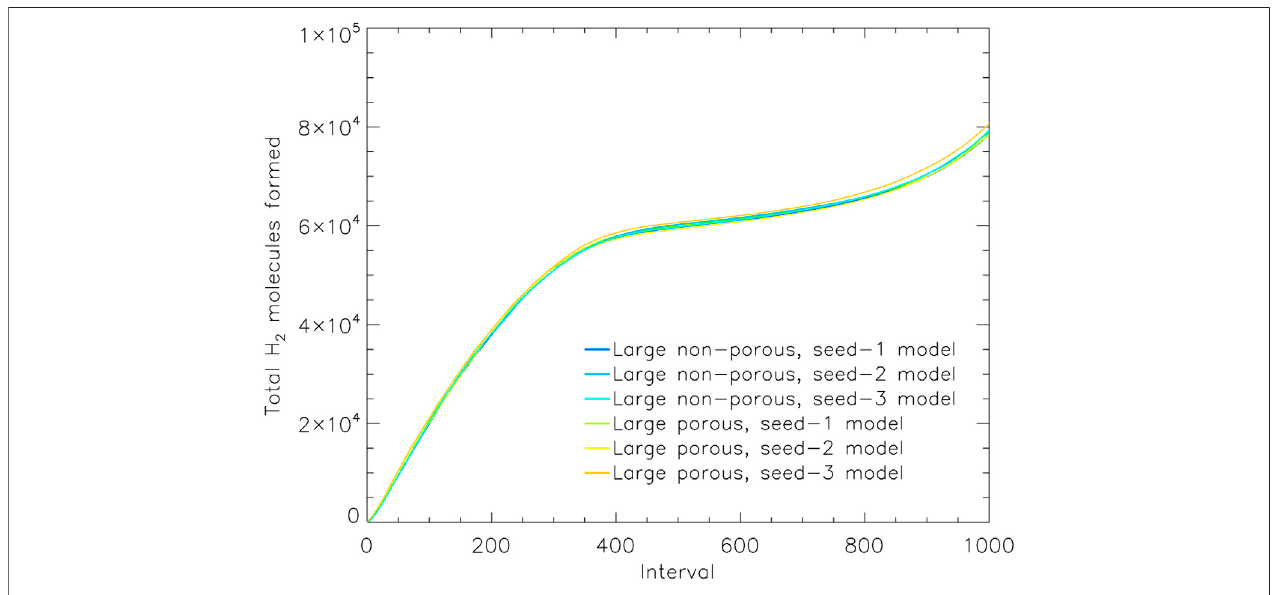
FIGURE 5 | The total count of hydrogen molecules formed in the model up to a given moment, vs. relative time intervals. All H 2 formed is shown, regardless of whether it is trapped in the ice, desorbed into the gas phase, or destroyed by chemical reactions. Data from the three runs for the large porous and non-porous grain models are shown. Interval 1,000 corresponds to the end time of the models shown, which are shown individually for each model in Table 4 .